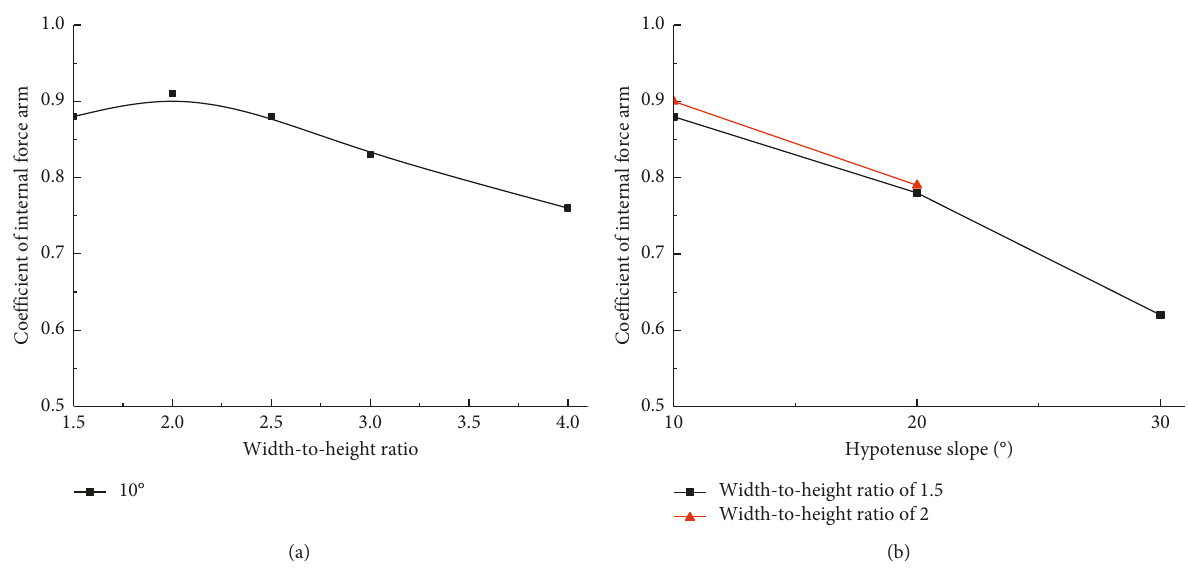
Figure 15: Analysis of the coefficients of the internal force arm. (a) Influence of the width-to-height ratio. (b) Influence of the hypotenuse Table 8: Comparison of the correction coefficients between the numerical and the recommended results. Model